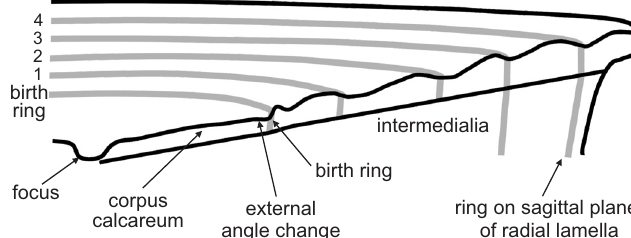
Fig. 2. Schematic drawing of a hypothetical shark centrum in hemisected view showing potential criteria used for age